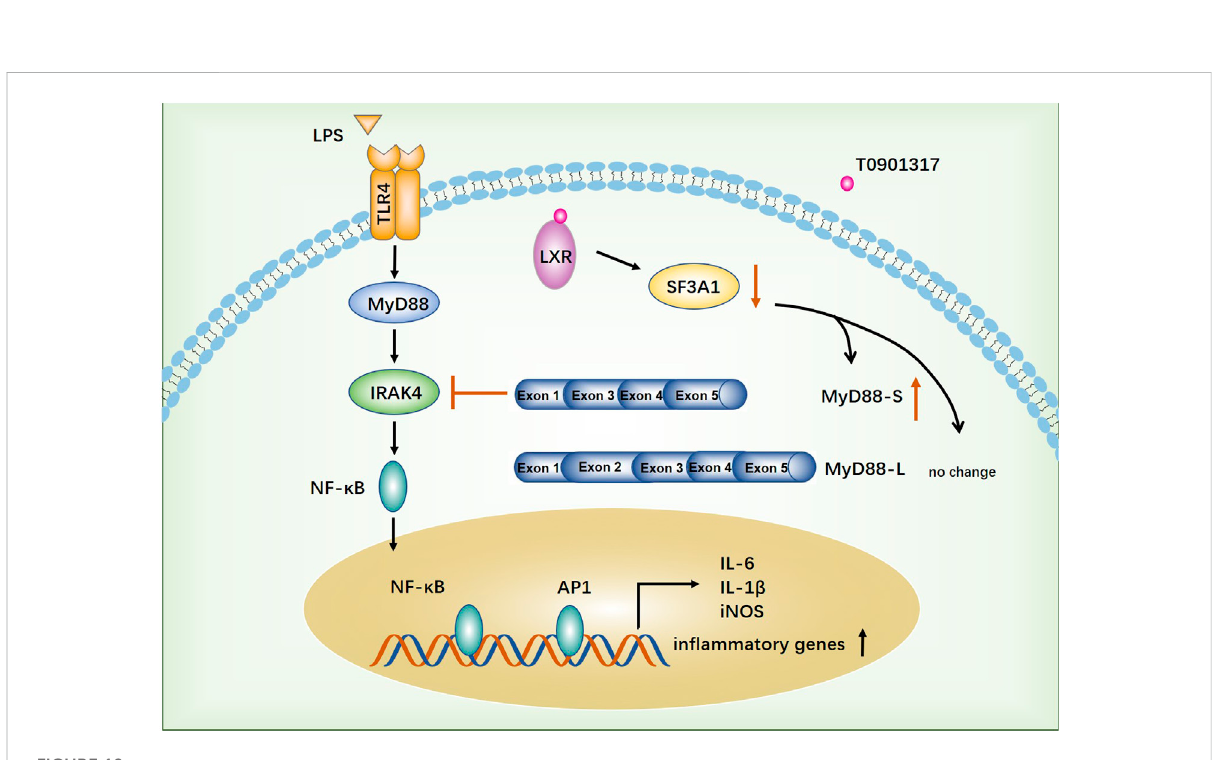
FIGURE 10 The proposed anti-in fl ammatory mechanism of T0901317. TLR4-mediated in fl ammatory pathway was activated by stimulating with LPS. T0901317, a potent LXR agonist, exhibits anti-in fl ammatory effect through increasing mRNA level of MyD88-S splicing isoform by down-regulating SF3A1 expression, leading to NF- κ B mediated inhibition of in fl ammatory response in RAW264.7